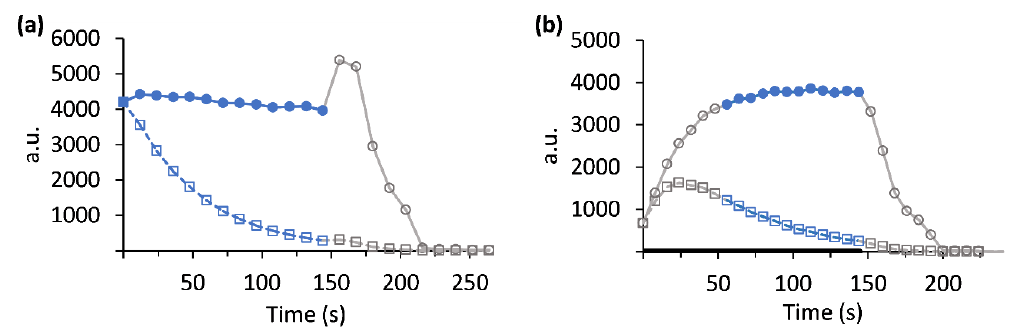
Figure 6. The hyperpolarized signal of [1- 13 C]pyruvate in arrested perfusion and continuous perfusion operation modes (Experimental designs 2 and 3, respectively, Methods) acquired with selective excitations. The hyperpolarized [1- 13 C]pyruvate signal (squares) and the corrected intensities (circles) are presented in arbitrary units for the experimental designs of perfusion arrest ( a ) and continuous perfusion ( b ). The points selected for analysis of the enzymatic rate are marked in blue full circles.